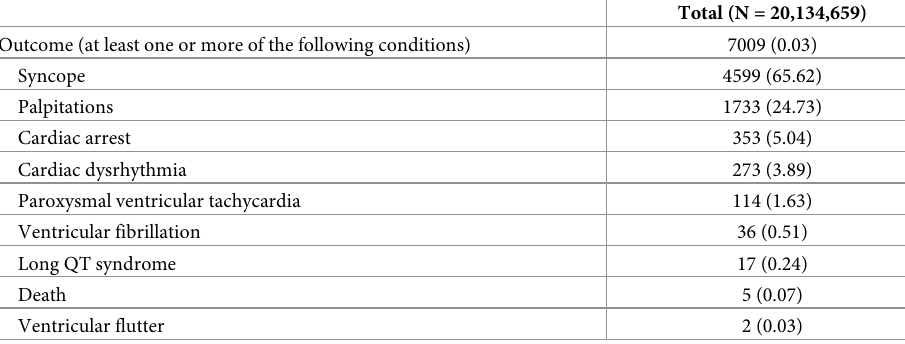
Table 2. Frequency of the outcome of cardiac